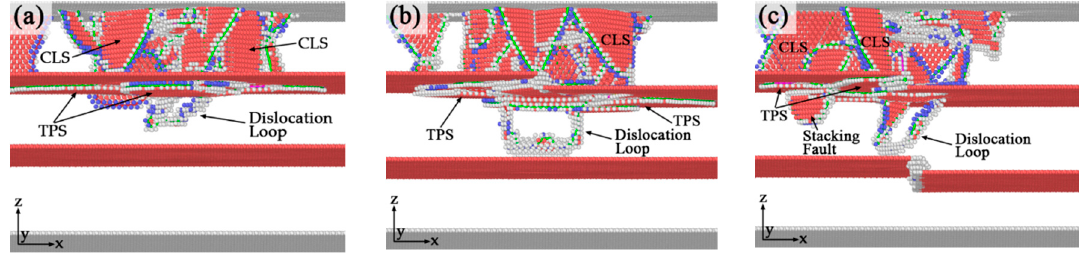
Figure 10. The atomistic configurations of dislocation transmissions of three different models. ( a ) TPT, d = 14.4 Å; ( b ) SDT, d = 16 Å; ( c ) TDT, d = 13.6 Å.